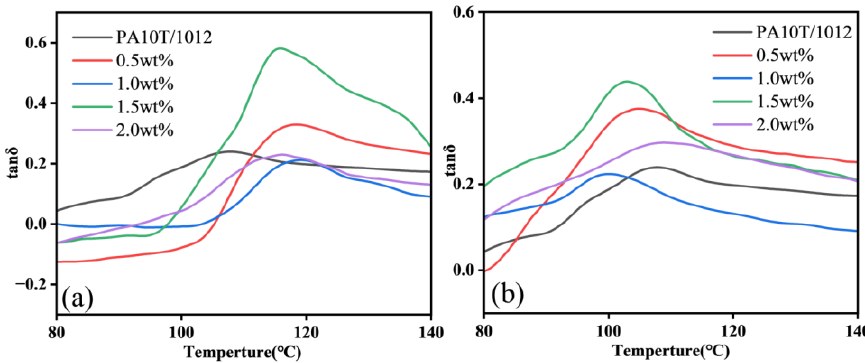
Figure 9. Dynamic damping factor (tan δ ) curves ( a ) SPA composites, ( b ) MPA composites. Figure 9. dynamic damping factor (tan  ) curves ( a ) SPA composites, ( b ) MPA composites. Table 4. Main thermomechanical parameters of SPA and MPA composites with different GO con- tent.